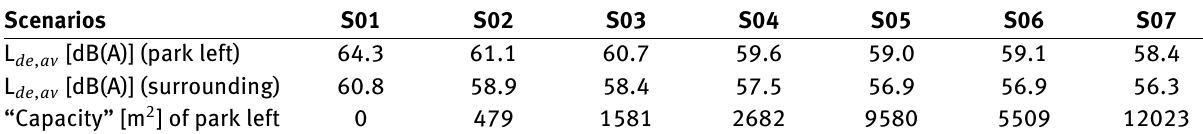
Table 6: L de , av average values for all scenarios.